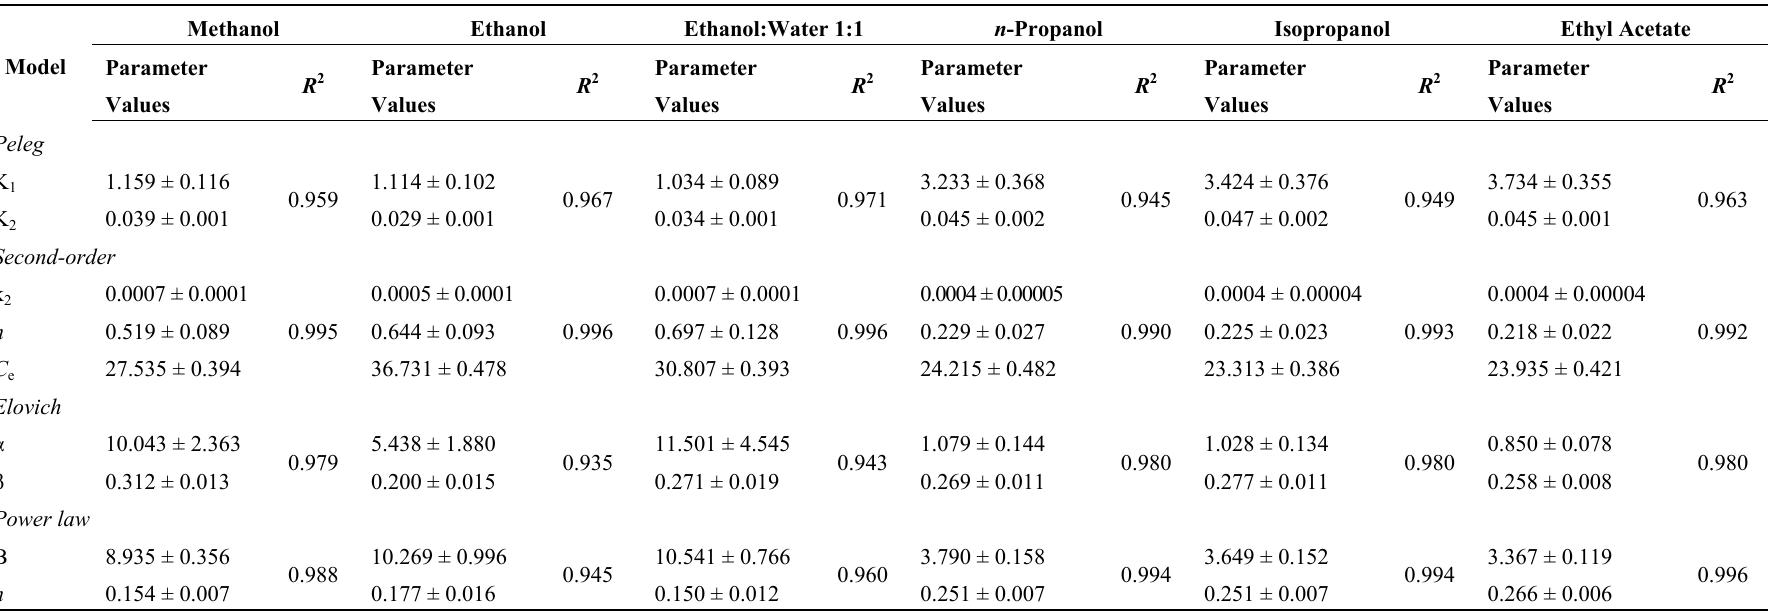
Table 2. Application of extraction models to phenolics extraction from olive leaves using various